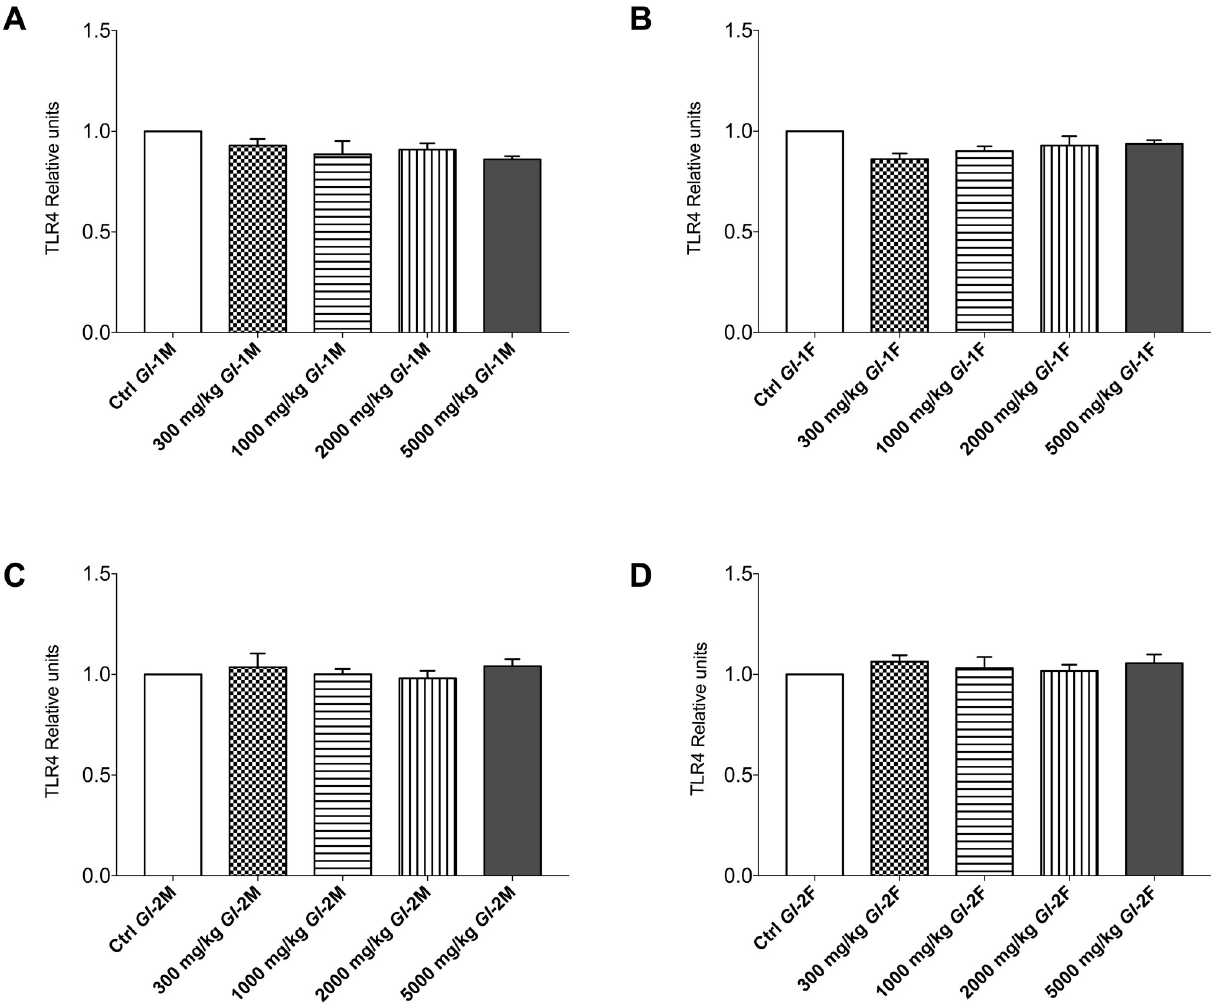
Fig 6. Renal TLR4 protein of kidney tissue from male (M) or female (F) Wistar rats fed with the control diet (Ctrl) and different doses of standardized Gl -1 or Gl -2 extracts of Ganoderma lucidum for 14 experimental days. Data are presented as mean ± SEM per experimental group. No significant differences were found ( p < 0.05). Densitometry data were generated from Western blots shown in Fig 8. A–B: Administration of the Gl -1 extract. C–D: Administration of the Gl -2 extract. The dose administered per experimental group is described in the materials and methods